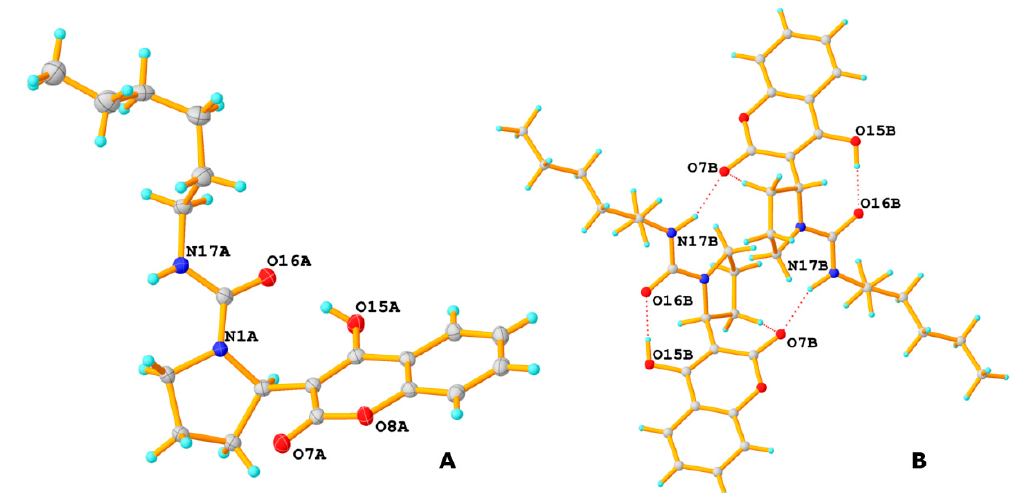
Figure 2. ( A ) Molecular structure of compound 8f in crystal (on the example of molecule a). Ellipsoids are shown with 50% probability; ( B ) H-bonded dimer in crystal of 8f (on the example of molecule b).